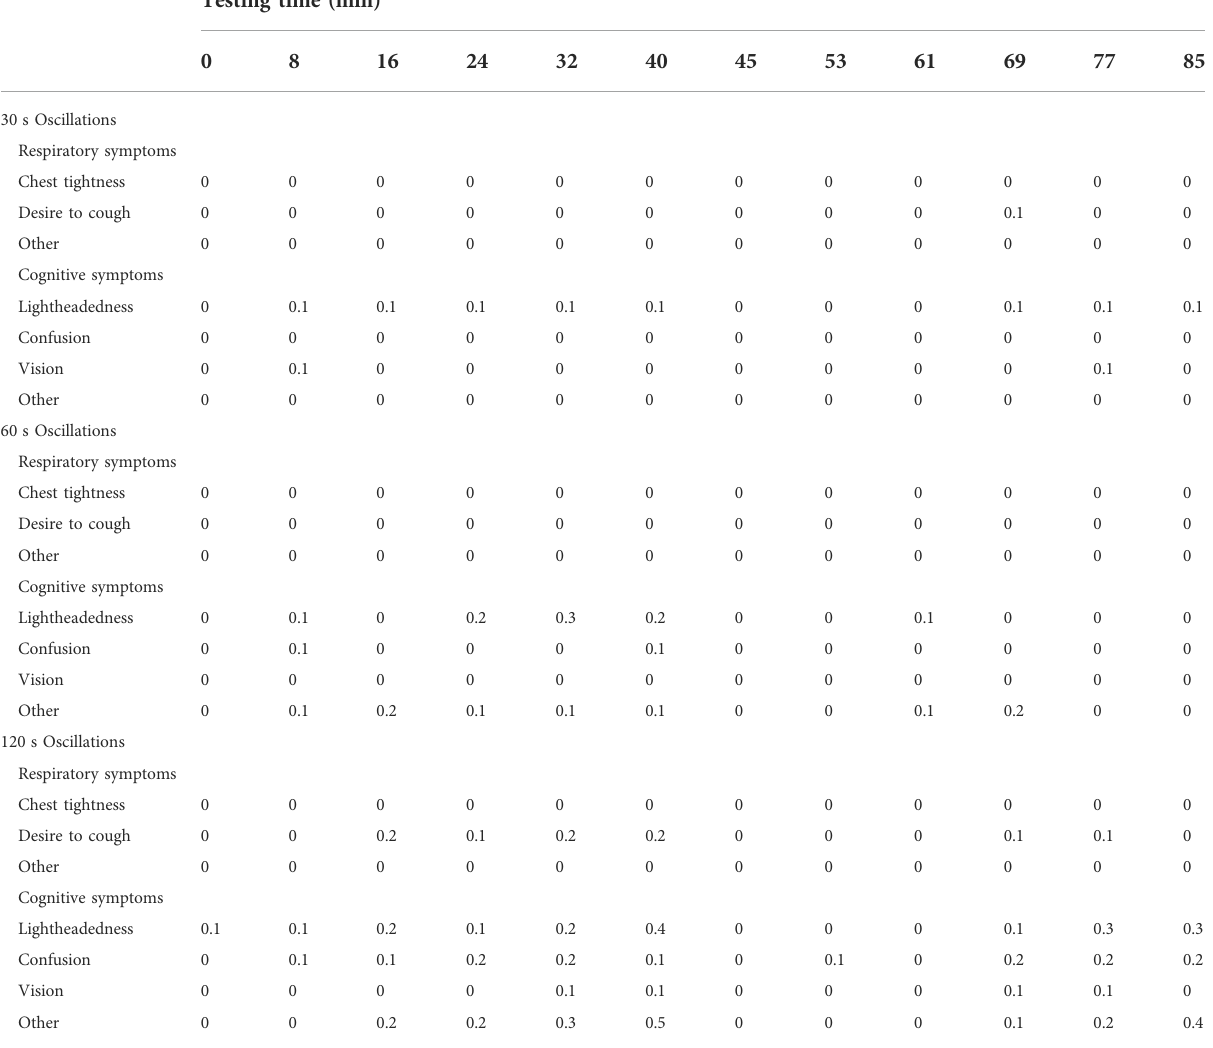
TABLE 2 Symptoms